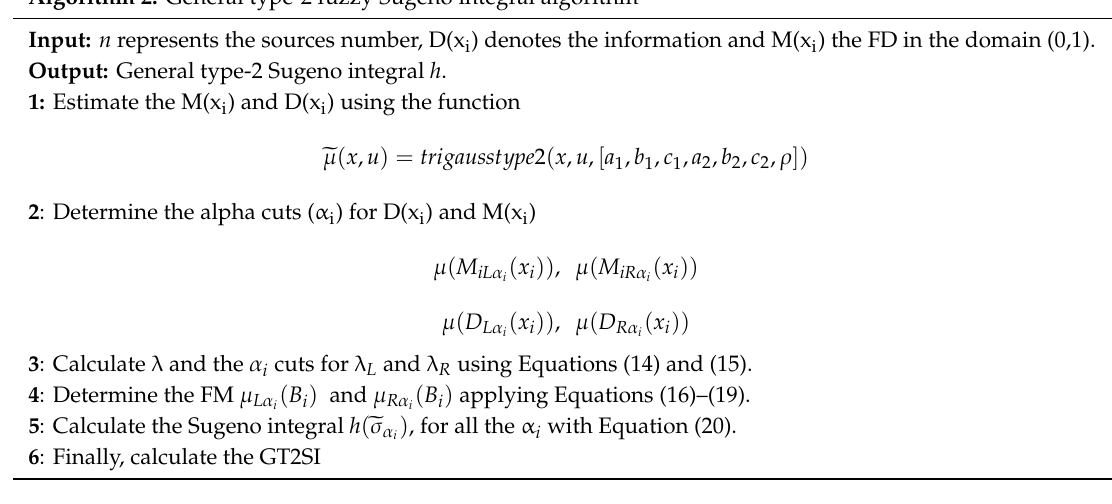
Algorithm 2: General type-2 fuzzy Sugeno integral